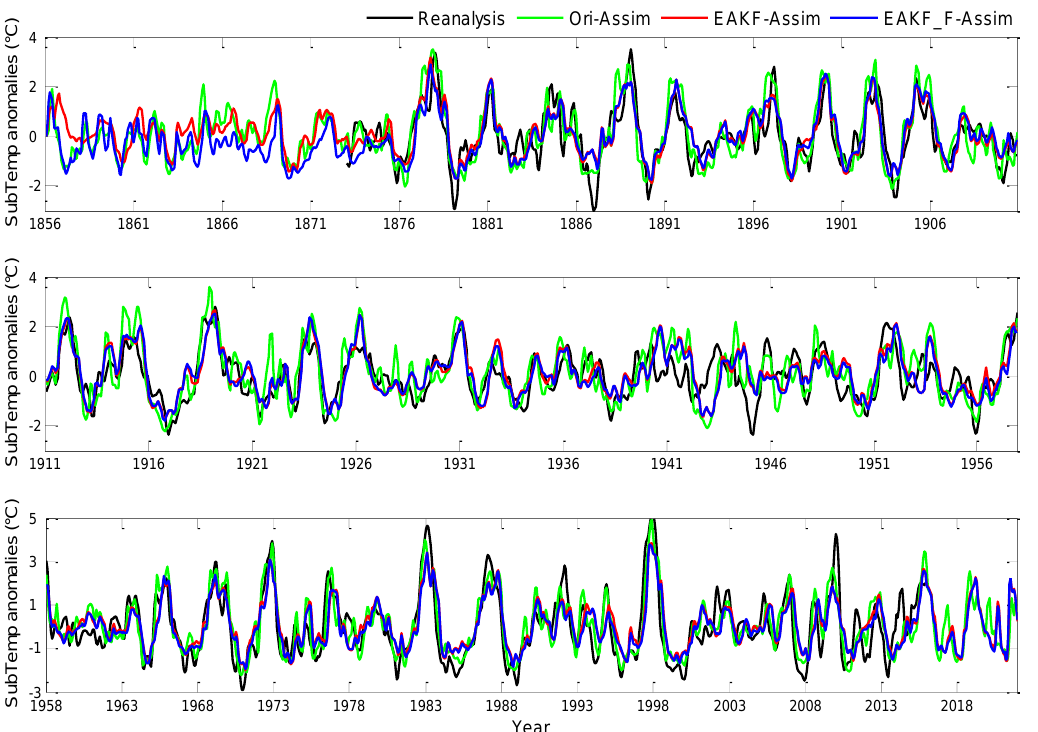
Figure 7. Evolution of Te anomalies averaged over the Niño3.4 region: SODA reanalysis and simulations from Ori-Assim, EAKF-Assim, and EAKF_F-Assim schemes in black, green, red, and blue lines, respectively.